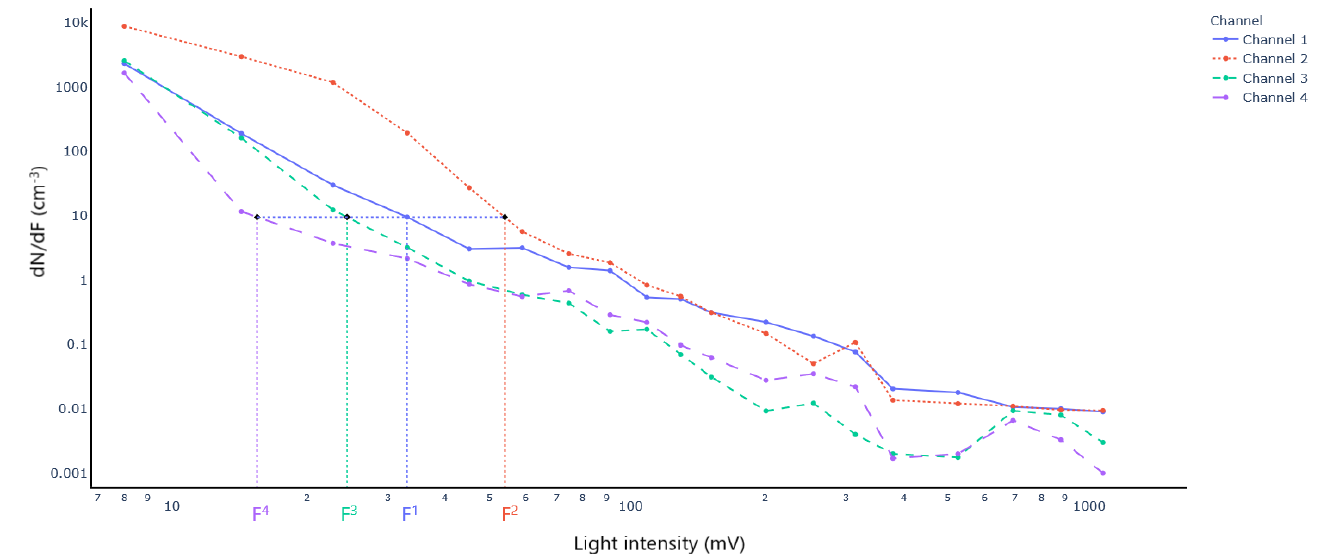
Figure 3. Principle for calculating the speciation indices using the light intensity distributions of the four channels (See Equations (1) and (2)).